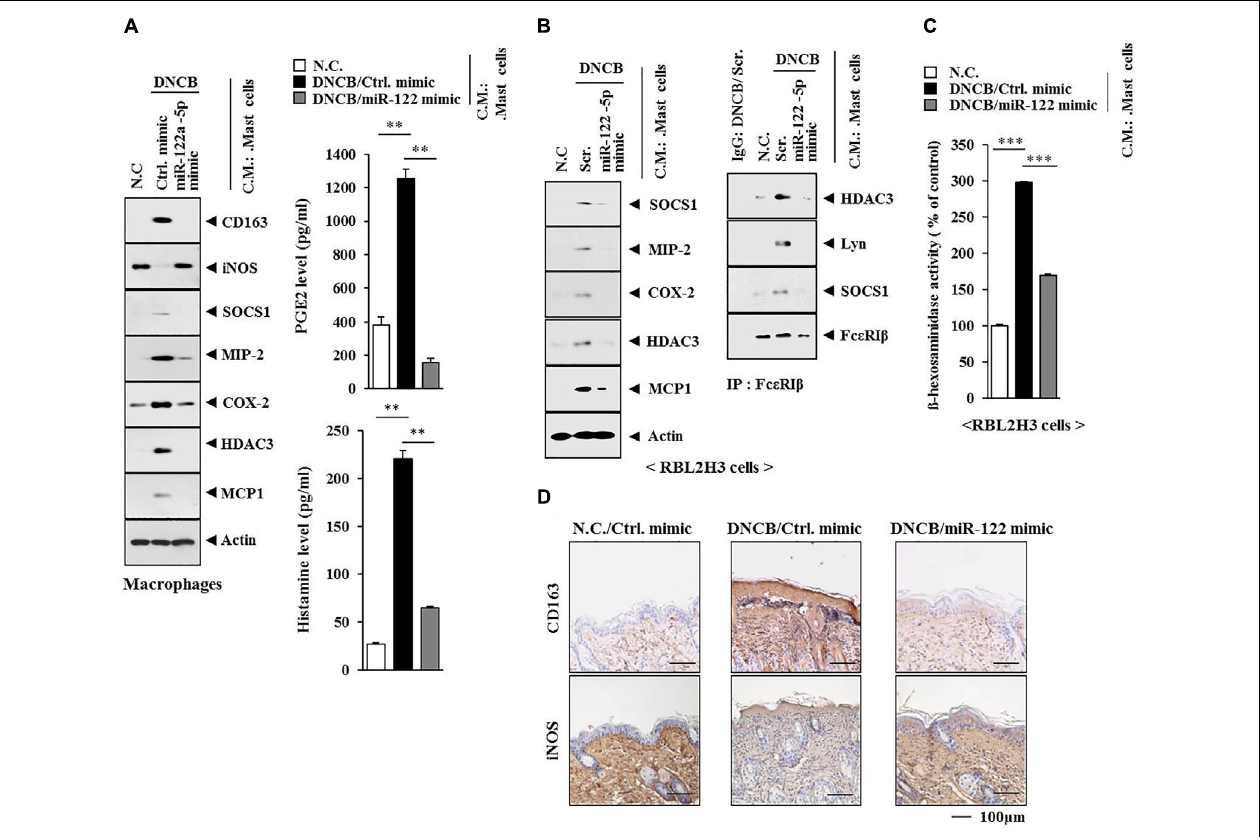
FIGURE 14 | Mast cell activation of macrophages occurs in AD. (A) Skin mast cells were isolated from BALB/c mice of each experimental group as described. The conditioned medium of mast cells isolated from BALB/c mouse of each experimental group was added to lung macrophages for 8 h, followed by western blot analysis (left). The conditioned medium of mast cells isolated from BALB/c mouse of each experimental group was subjected to PGE2 level assays and histamine release assays (right). ∗∗ p < 0.005. C.M., conditioned medium. (B) Same as (A) except that rat basophilic leukemia cells, equivalent of mouse mast cells, were employed. Western blot and immunoprecipitation were performed. Tissue lysates from BALB/c mouse injected with ctrl. mimic following the induction of AD by DNCB were immunoprecipitated with isotype-matched IgG antibody (2 µ g/ml). (C) Same as (B) except that ß-hexosaminidase activity assays were performed. ∗∗∗ p < 0.0005. (D) Skin tissues of BALB/c mice of each experimental group were subjected to immunohistochemical staining. Scale bar represents 100 µ